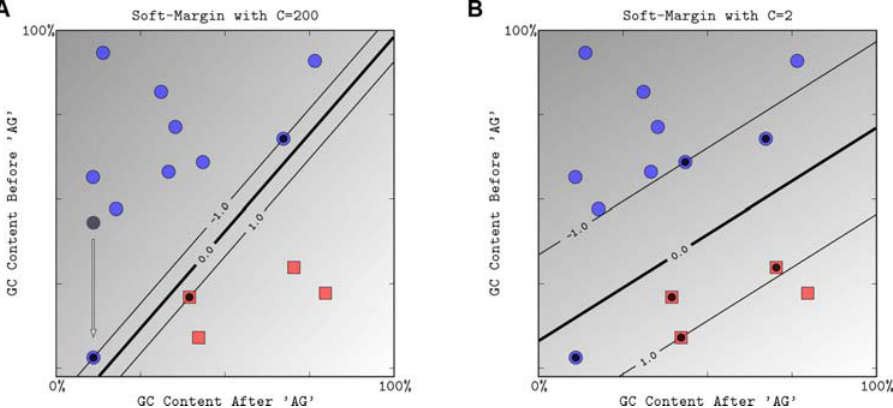
Figure 3. The effect of the soft-margin constant, C , on the decision boundary. We modified the toy dataset by moving the point shaded in gray to a new position indicated by an arrow, which significantly reduces the margin with which a hard-margin SVM can separate the data. (A) We show the margin and decision boundary for an SVM with a very high value of C , which mimics the behavior of the hard-margin SVM since it implies that the slack variables j i (and hence training mistakes) have very high cost. (B) A smaller value of C allows us to ignore points close to the boundary, and increases the margin. The decision boundary between negative examples and positive examples is shown as a thick line. The thin lines are on the margin (discriminant value equal to 2 1 or + 1).